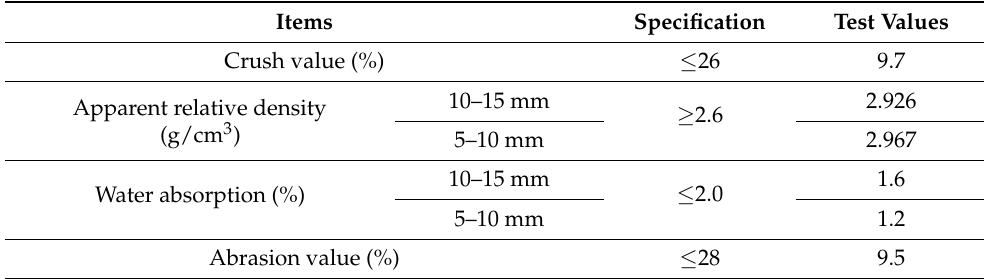
Table 3. Technical indices of the coarse